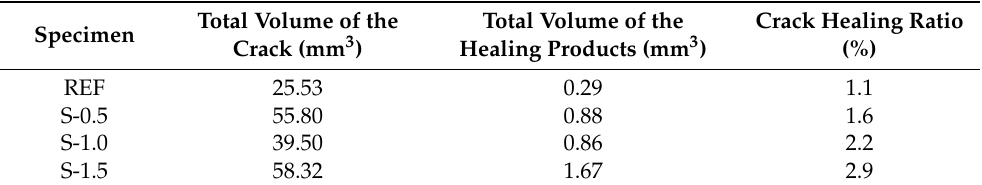
Table 3. Crack healing ratios of specimens.